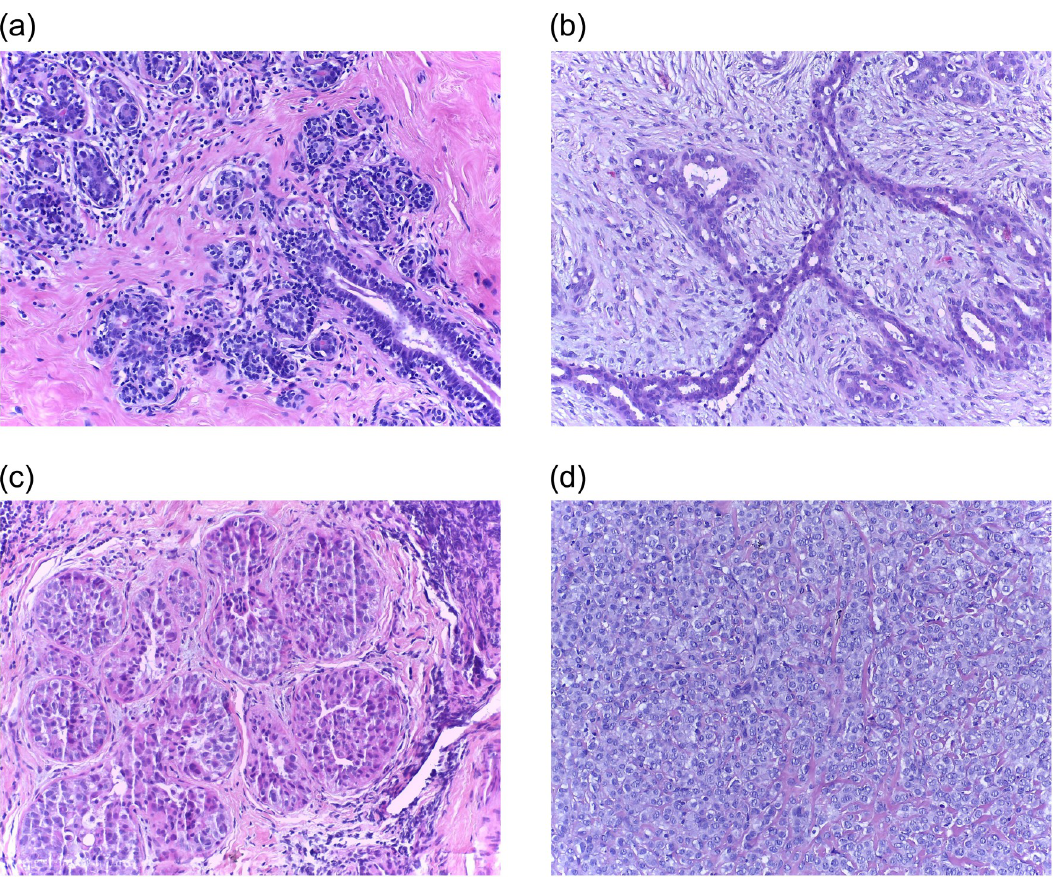
Fig 7. Examples of Bioimaging 2015 dataset. (a) Normal; (b) Benign; (c) In situ; (d) Invasive.